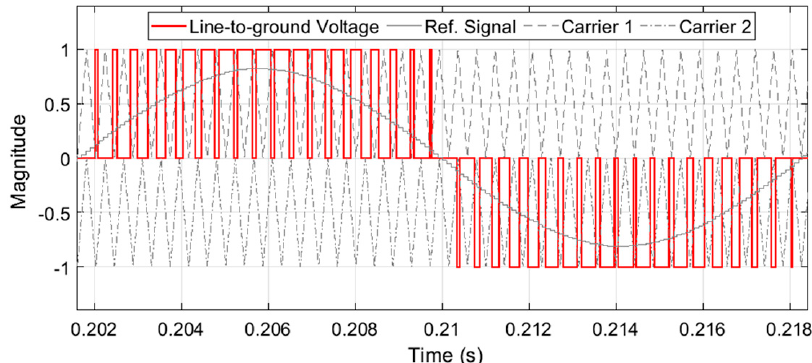
Figure 21. SPWM for a three-level NPC converter with a pulse number of 39.